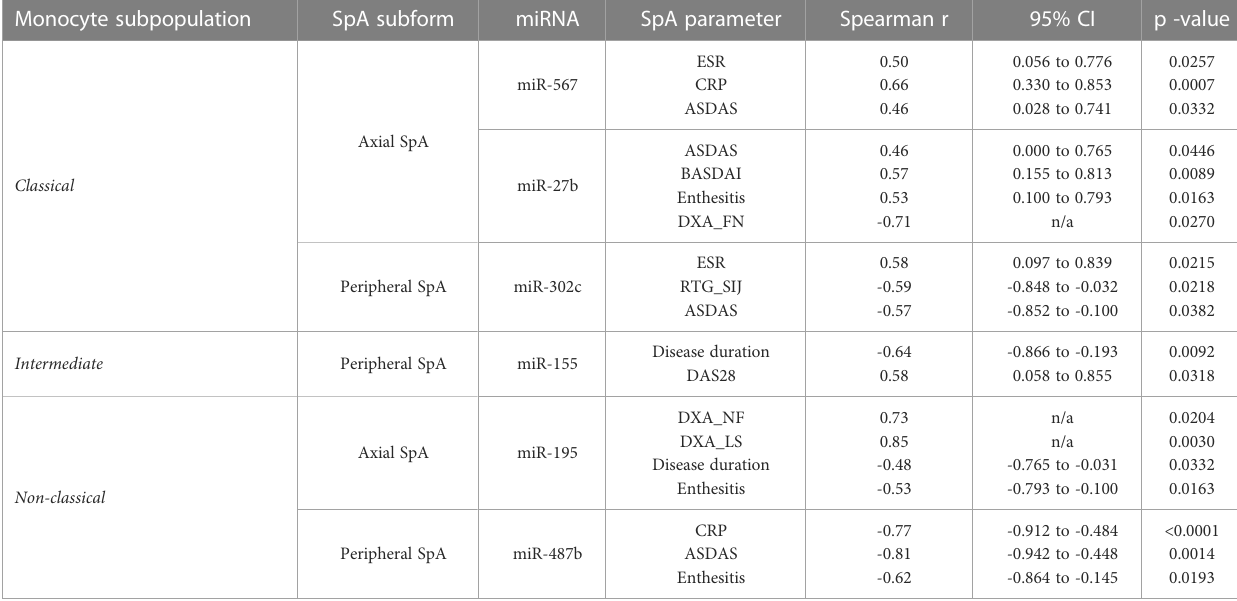
TABLE 2 Spearman correlations between miRNA expression and SpA patients ’ clinical data. Monocyte